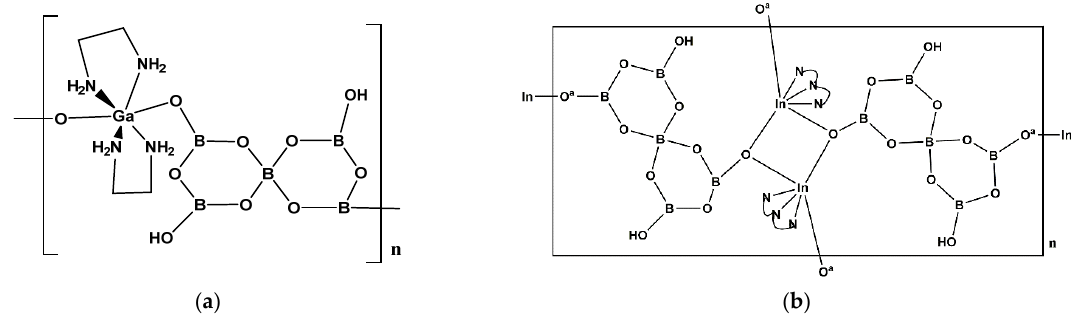
Figure 7. The building unit of ( a ) [Ga(en) 2 {B 5 O 8 (OH) 2 }] n ·nH 2 O ( 22 ), and ( b ) the dimeric In (III) centers in [In(dien){B 5 O 8 (OH) 2 }] n ( 27 ).